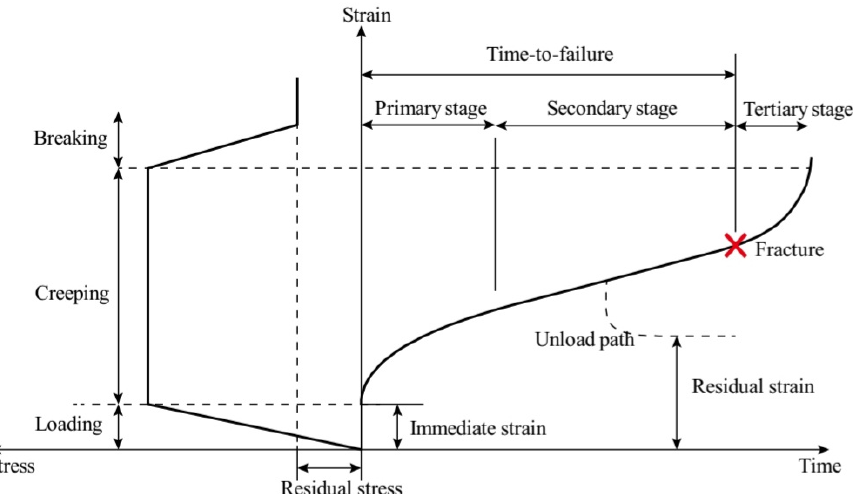
Figure 3. Illustration time-to-failure for brittle rocks from a standard creep curve (from [110]; Copy- right©2022, with permission from the publisher, License No. 5333750843038).